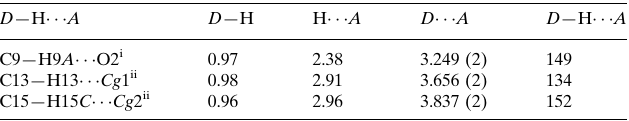
Hydrogen-bond geometry (A˚ , (cid:3) ). Cg 1 and Cg 2 are the centroids of the C2–C7 and C1/C2/C7/C8/O1 rings,